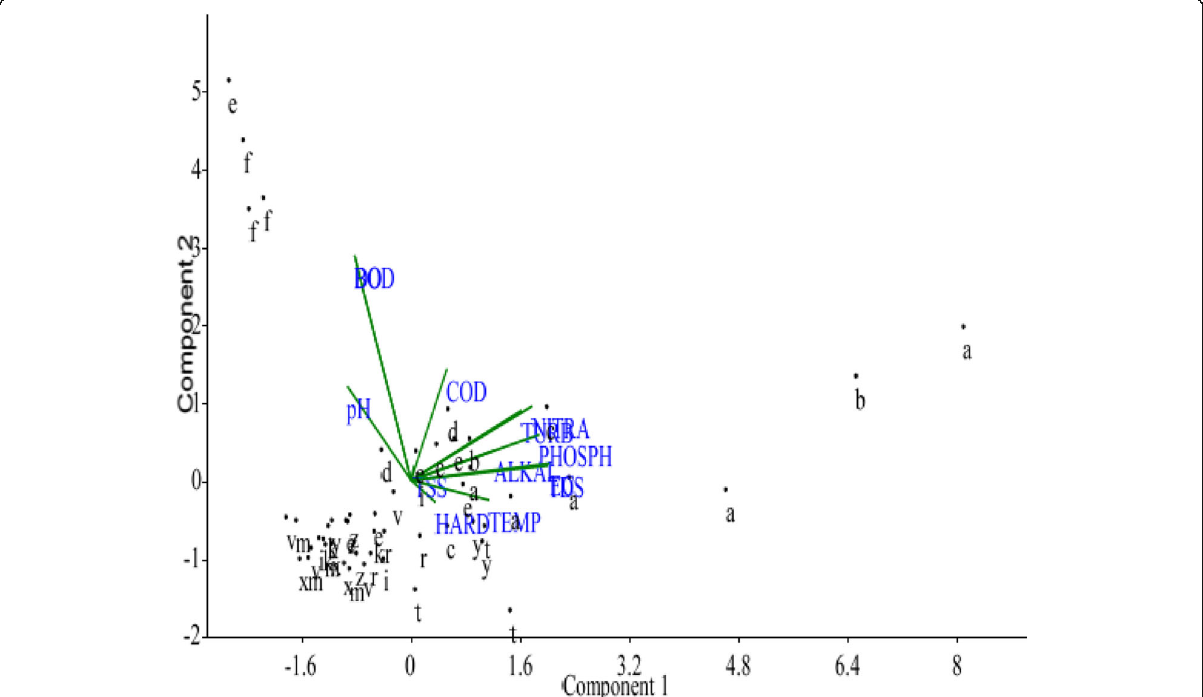
Fig. 2 Interaction effect of the physicochemical parameters of the rock pools amongst the inselbergs. Key: a, Dumbi; b, Danmagaji; c, Hanwa; d, Dutsen-Abba; e, Kufena; f, Wusasa; g, Zango-Aya; i, Kujama; k, Tudu-Mare; m, Kagoma; r, Kajuru; t, Jere; v, Kwoi; x, Nok; y, Chori; z,